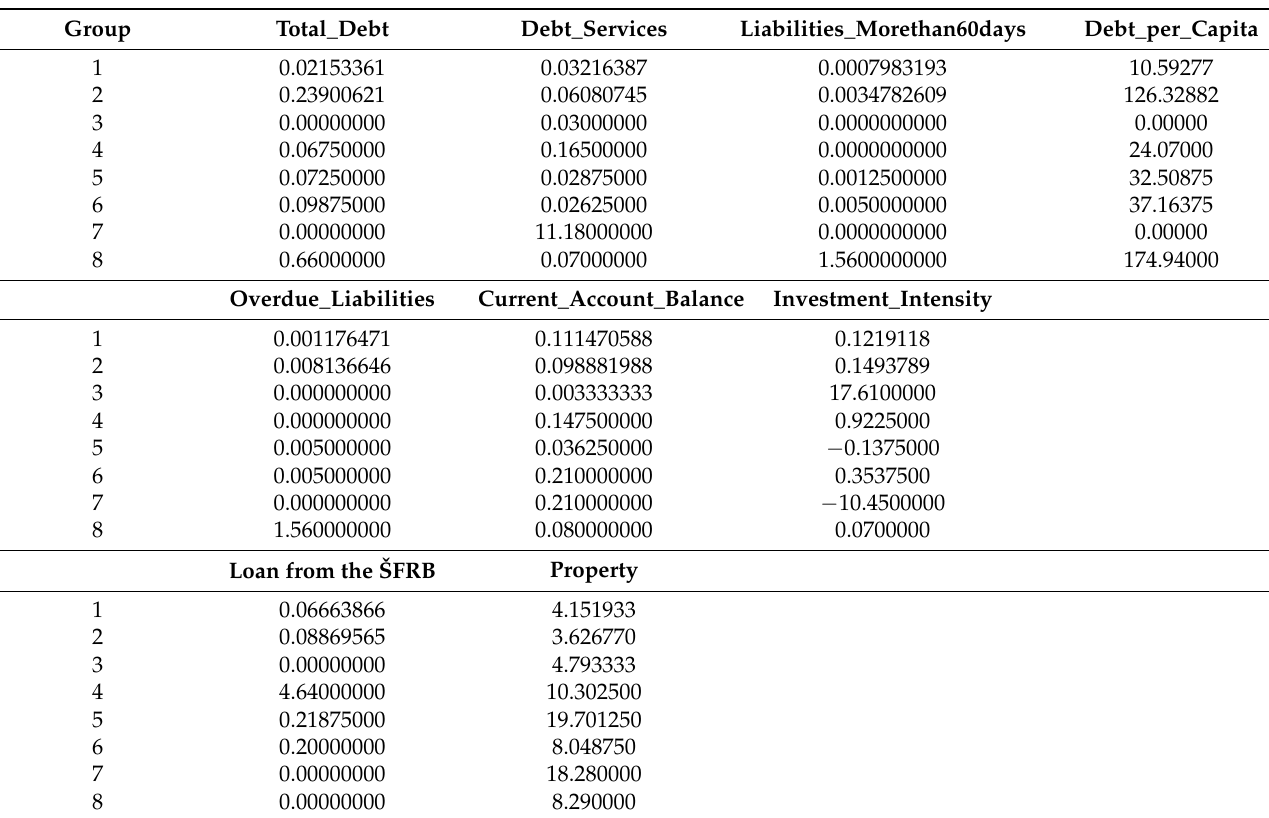
Table 4. Centroids of